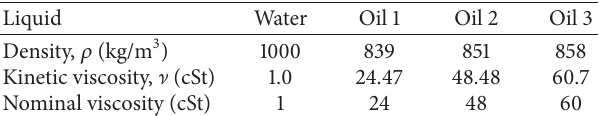
Table 1: Viscosity and density of working